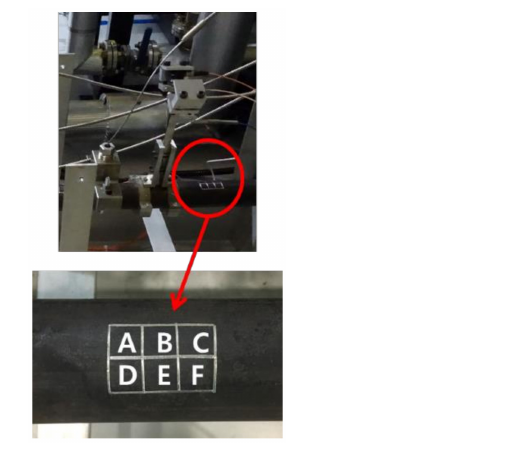
Figure 10. A grid for measuring ultrasonic testing at room temperature in the same direction next to two installed